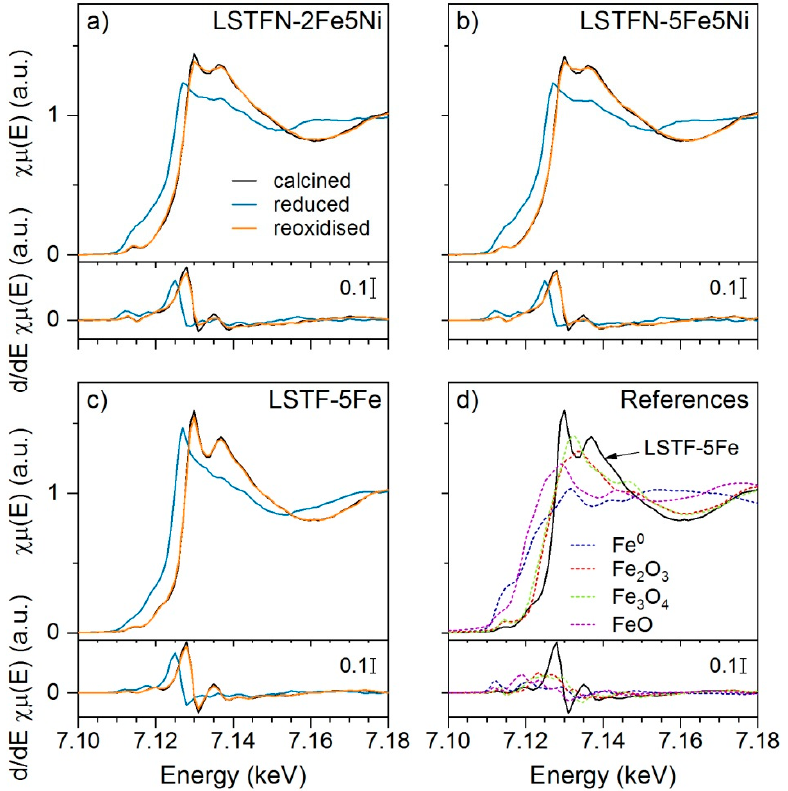
Figure 9. Normalized Fe K-edge (7.112 keV) XANES spectra of ( a ) calcined, reduced (800 ◦ C, 10 vol.% H 2 /Ar, 15 h) and reoxidized (800 ◦ C, 20 vol.% O 2 /N 2 , 2 h) LSTFN-2Fe5Ni, ( b ) LSTFN-5Fe5Ni, ( c ) LSTF-5Fe. ( d ) XANES spectra of LST-5Fe, Fe 0 , Fe 2 O 3 , Fe 3 O 4 and FeO reference materials. The first derivative of the normalized spectra is shown in the bottom panels.